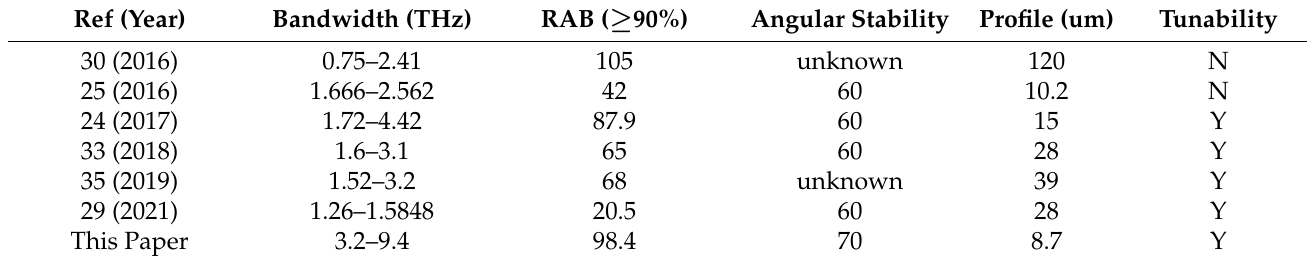
Table 1. Comparison between our proposed results and some previous